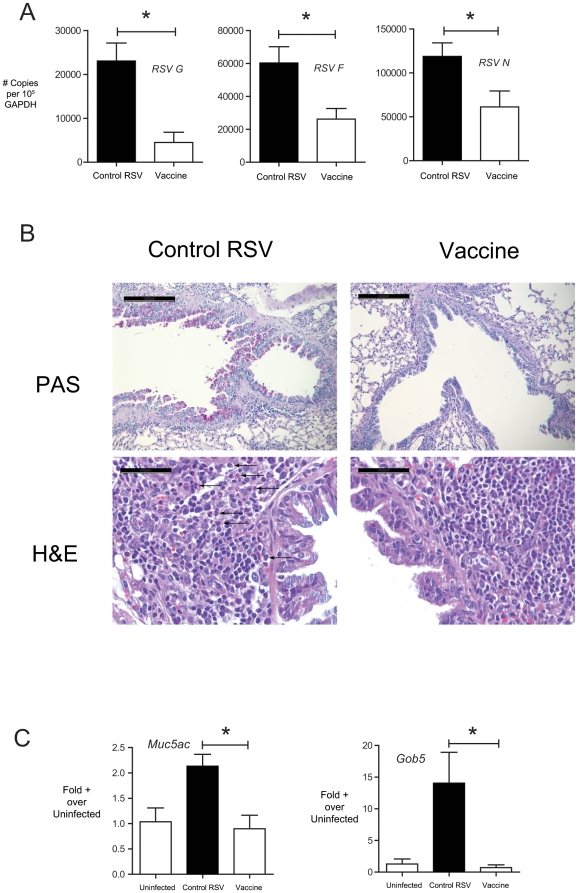
Vaccination of mice with NE-RSV attenuates disease following intranasal challenge with live RSV.Immunized mice were vaccinated intranasally (i.n.) twice at day 0 and day 28 with NE-RSV (105 PFU equivalent). Control and vaccinated mice were challenged at day 56 (i.n.) with 105 PFU live RSV. In (A), the expression of virus transcripts and were determined at day 4 post-infection via QPCR of lung RNA. (B) depicts representative histology (Periodic Acid Schiff's, PAS; Hematoxylin and Eosin, H&E) from control RSV infected and NE-RSV vaccinated mice at day 8 post-infection. In the top two panels, magnification bars are 200 µm in length and 50 µm in the bottom two panels. Arrows indicate airway-associated eosinophils in control RSV infected mice. In (C), the expression of Muc5ac and Gob5 were assessed at day 8 post-infection via QPCR of lung RNA.